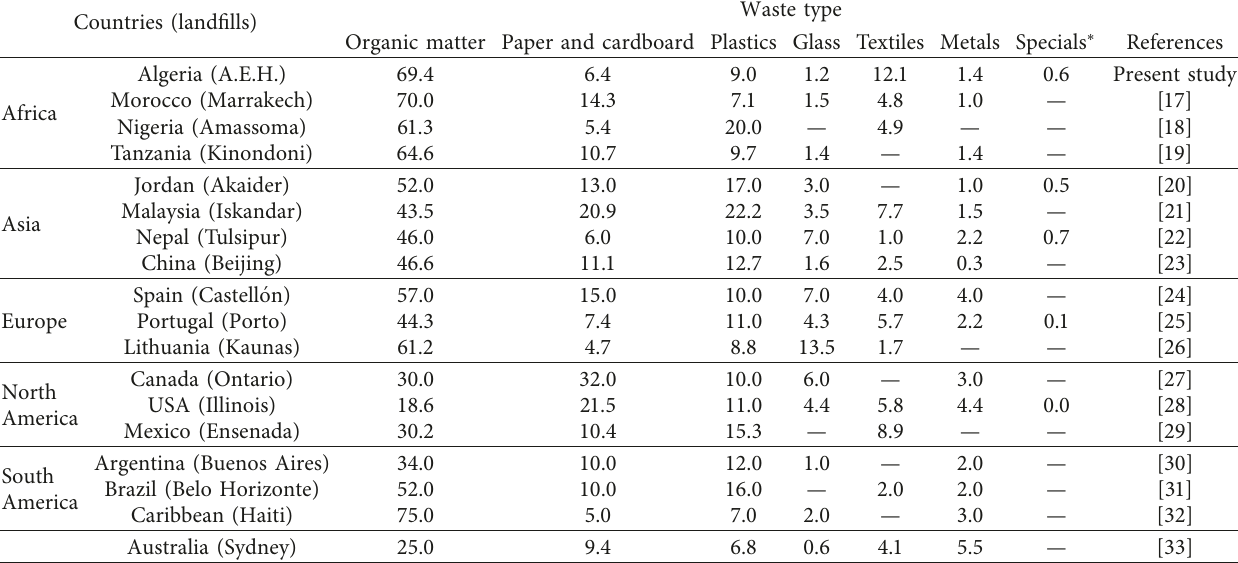
Table 1: Comparison of the physical composition values of the household and equivalent waste collected from some countries of different continents.